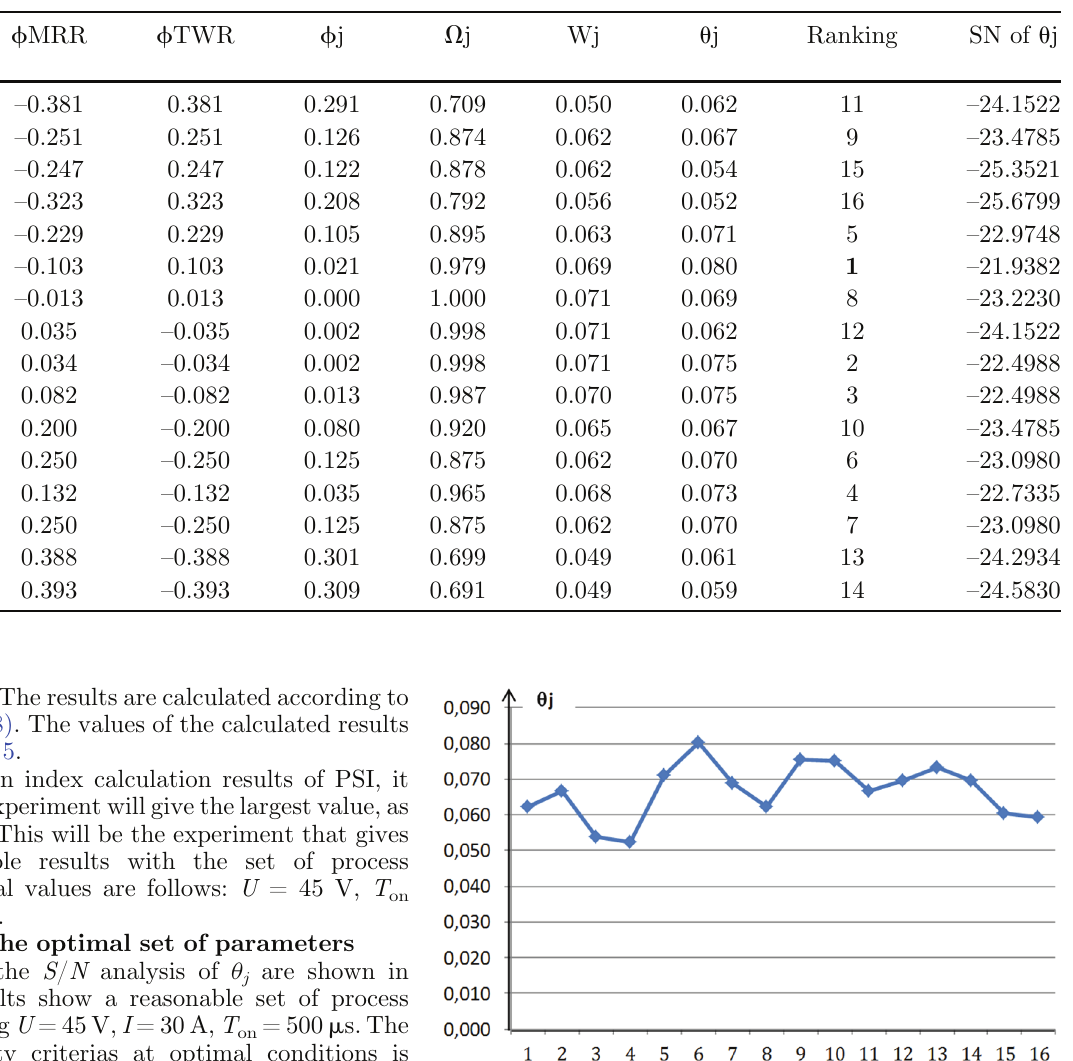
Table 5. The values of conversion parameters and priority index.